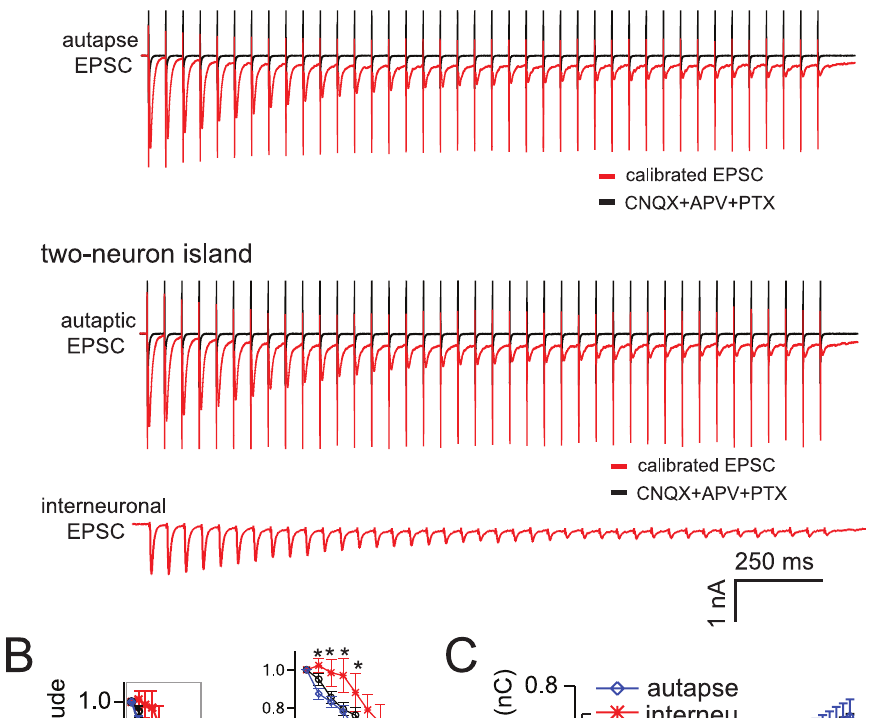
PLOS ONE | www.plosone.org